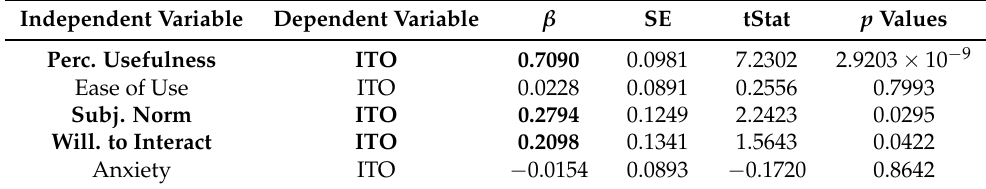
Table 8. Results of the construction of a multiple regression model for our data. Significant values are written in